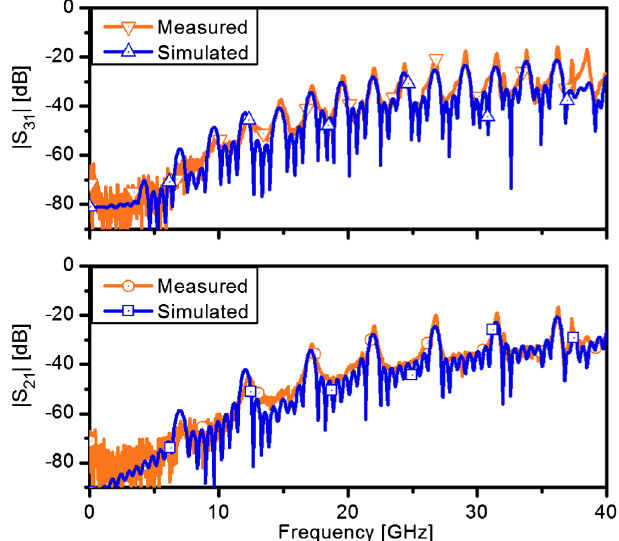
FIG. 8. Comparison between simulation and measurements. Top: Between neighboring ports. Bottom: Between opposite ports.